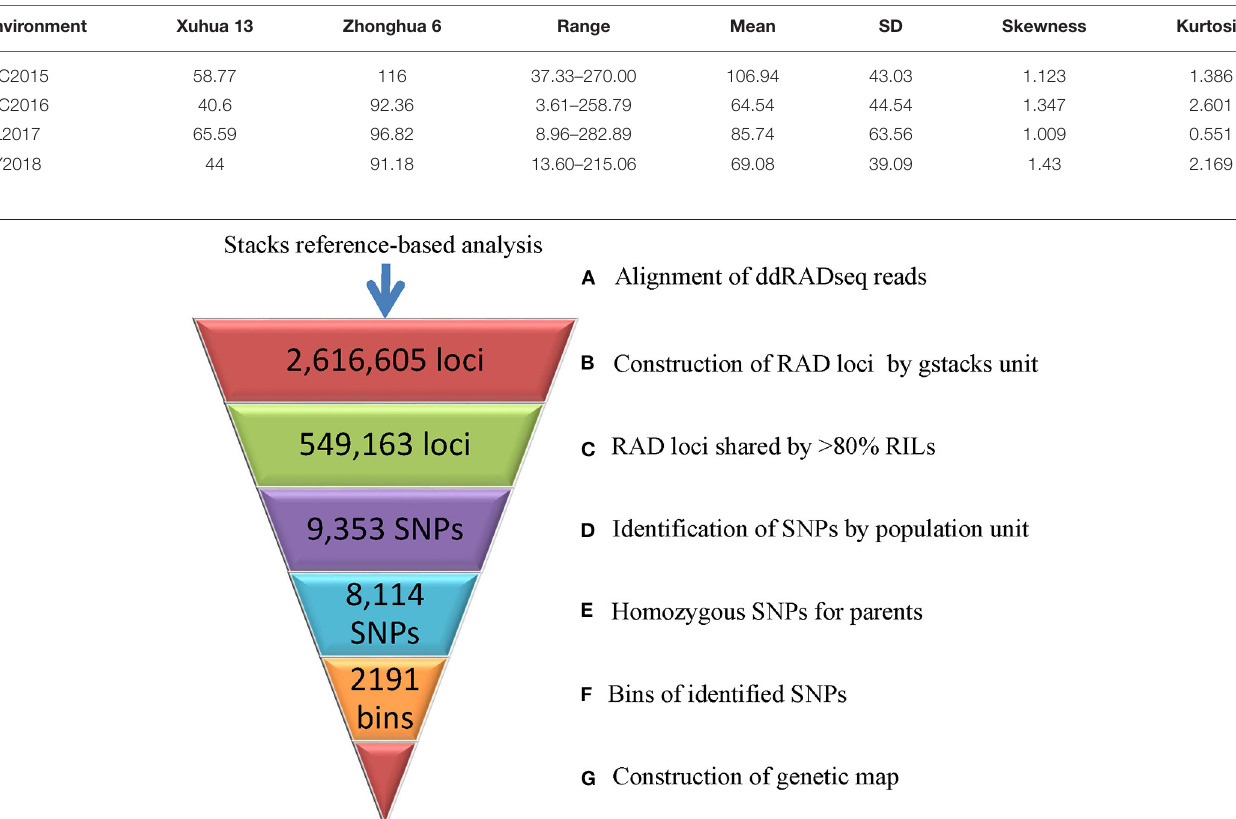
Frontiers in Plant Science |